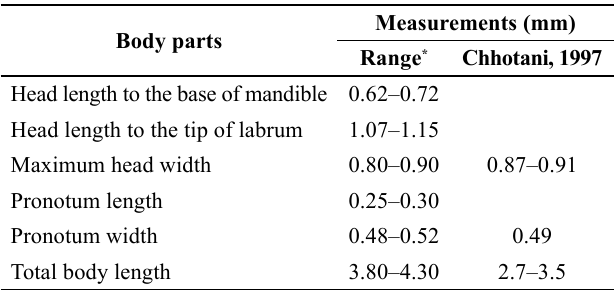
Table 2 . Measurements of workers of Pericapritermes ceylonicus (Holmgren, 1911)